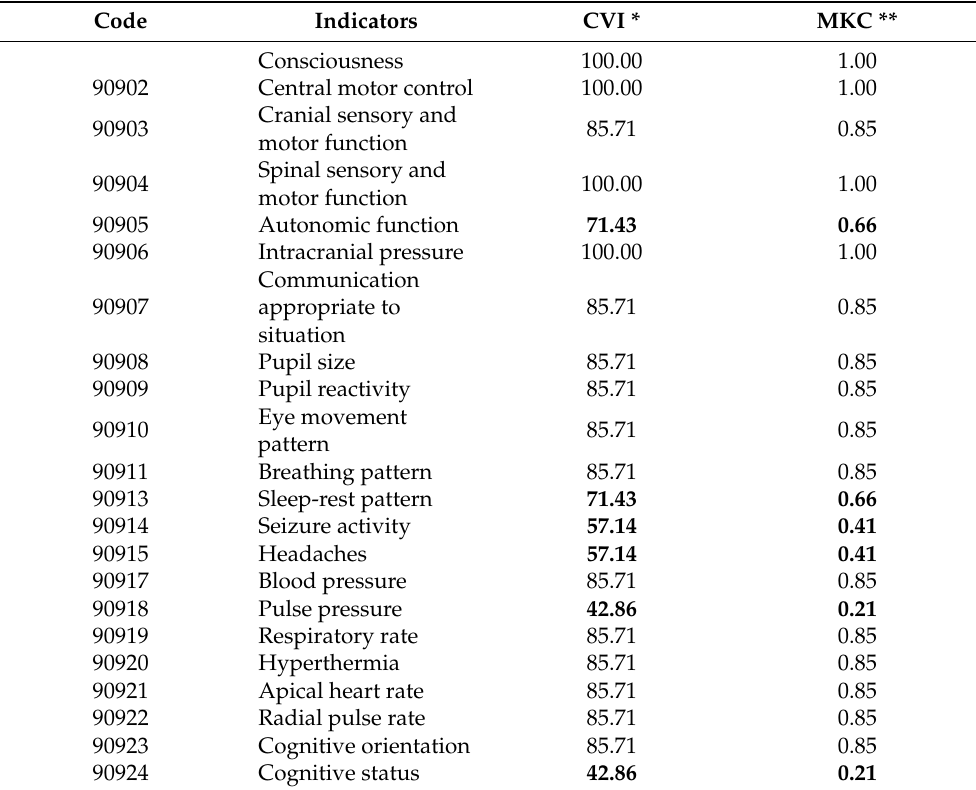
Table 1. Agreement between the experts based on the relevance criteria for indicators of the nursing outcome “Neurological